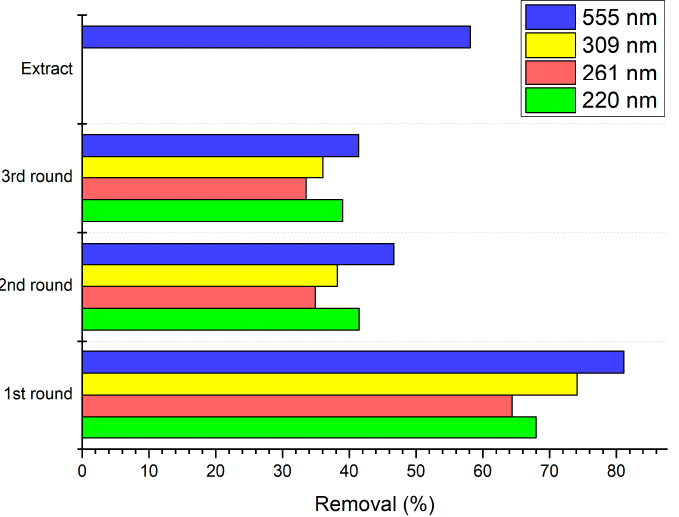
Figure 6. Removal of the dye after 30 min as the decrease in the absorbance values of measured peaks at 220, 261, 309, and 555 nm in the 1st, 2nd, and 3rd round of the photocatalysis, as well as degradation of the 555 nm peak by plant extract.